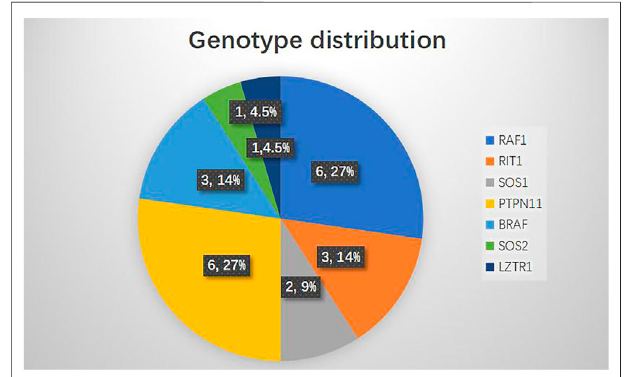
FIGURE 2 | Genotype distribution in NS patients (N =